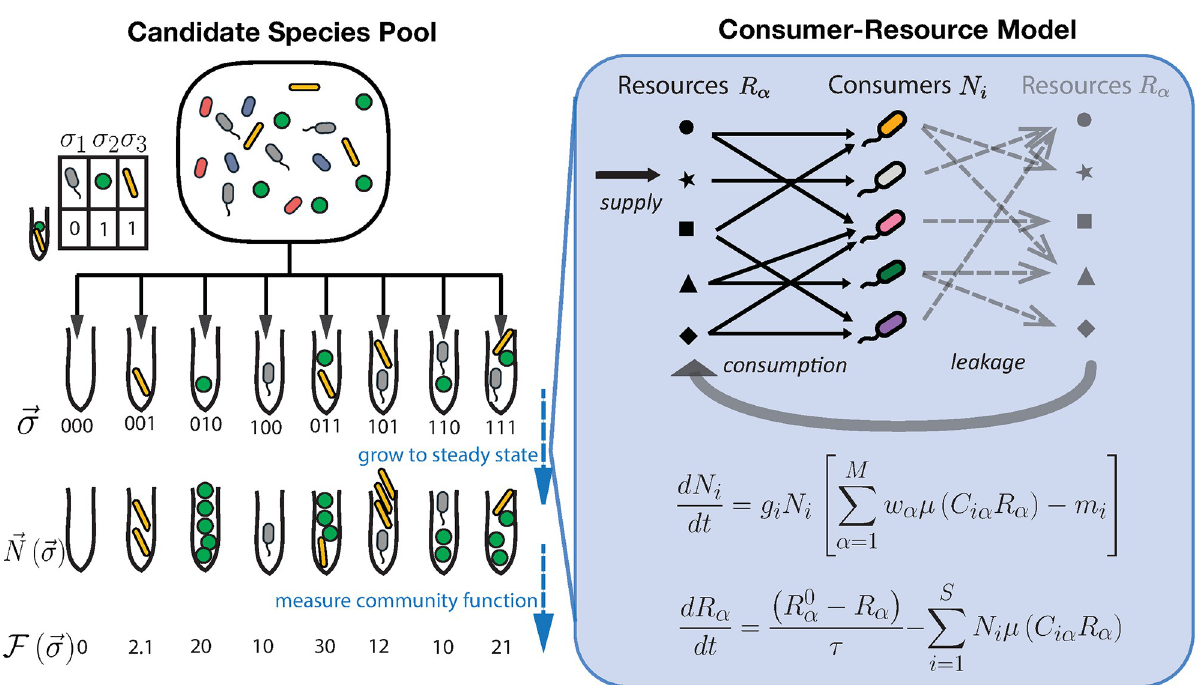
Fig 1. An ecological landscape framework for community optimization. We consider the problem of assembling an ecological community from a pool of S candidate species that is optimal at performing a desired function. The candidate species in the pool are indexed from 1 to S . A test community is seeded with a subset of the candidate species. The composition of the community is encoded in ~ s using 0 for absence and 1 for presence for each of the species. The test communities are allowed to grow until they reach a steady state. The species abundances in the steady-state community is ~ N ð ~ s Þ , and the community function is F ð ~ s Þ . The growth of the community to steady-state is simulated by consumer-resource models, illustrated on the right. The growth rate depends on its ability to consume resources and death occurs by dilution or mortality. In models with leakage (gray), metabolic byproducts can be leaked and used by other species. Equations shown correspond to the scenario without metabolic leakage; see methods for further explanation and model equations with